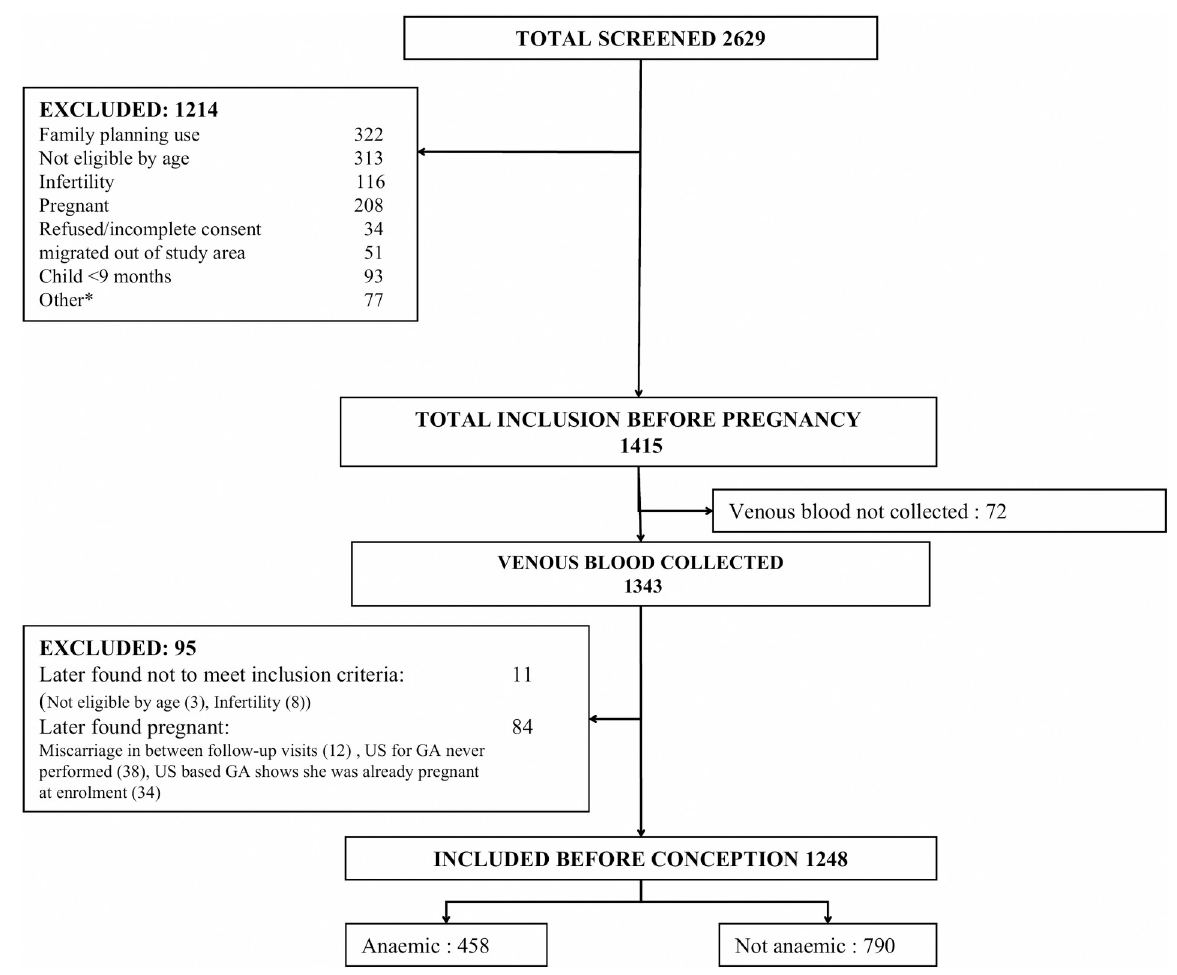
Fig 1. Flow chart of participants in FOETALforNCDprepregnancy